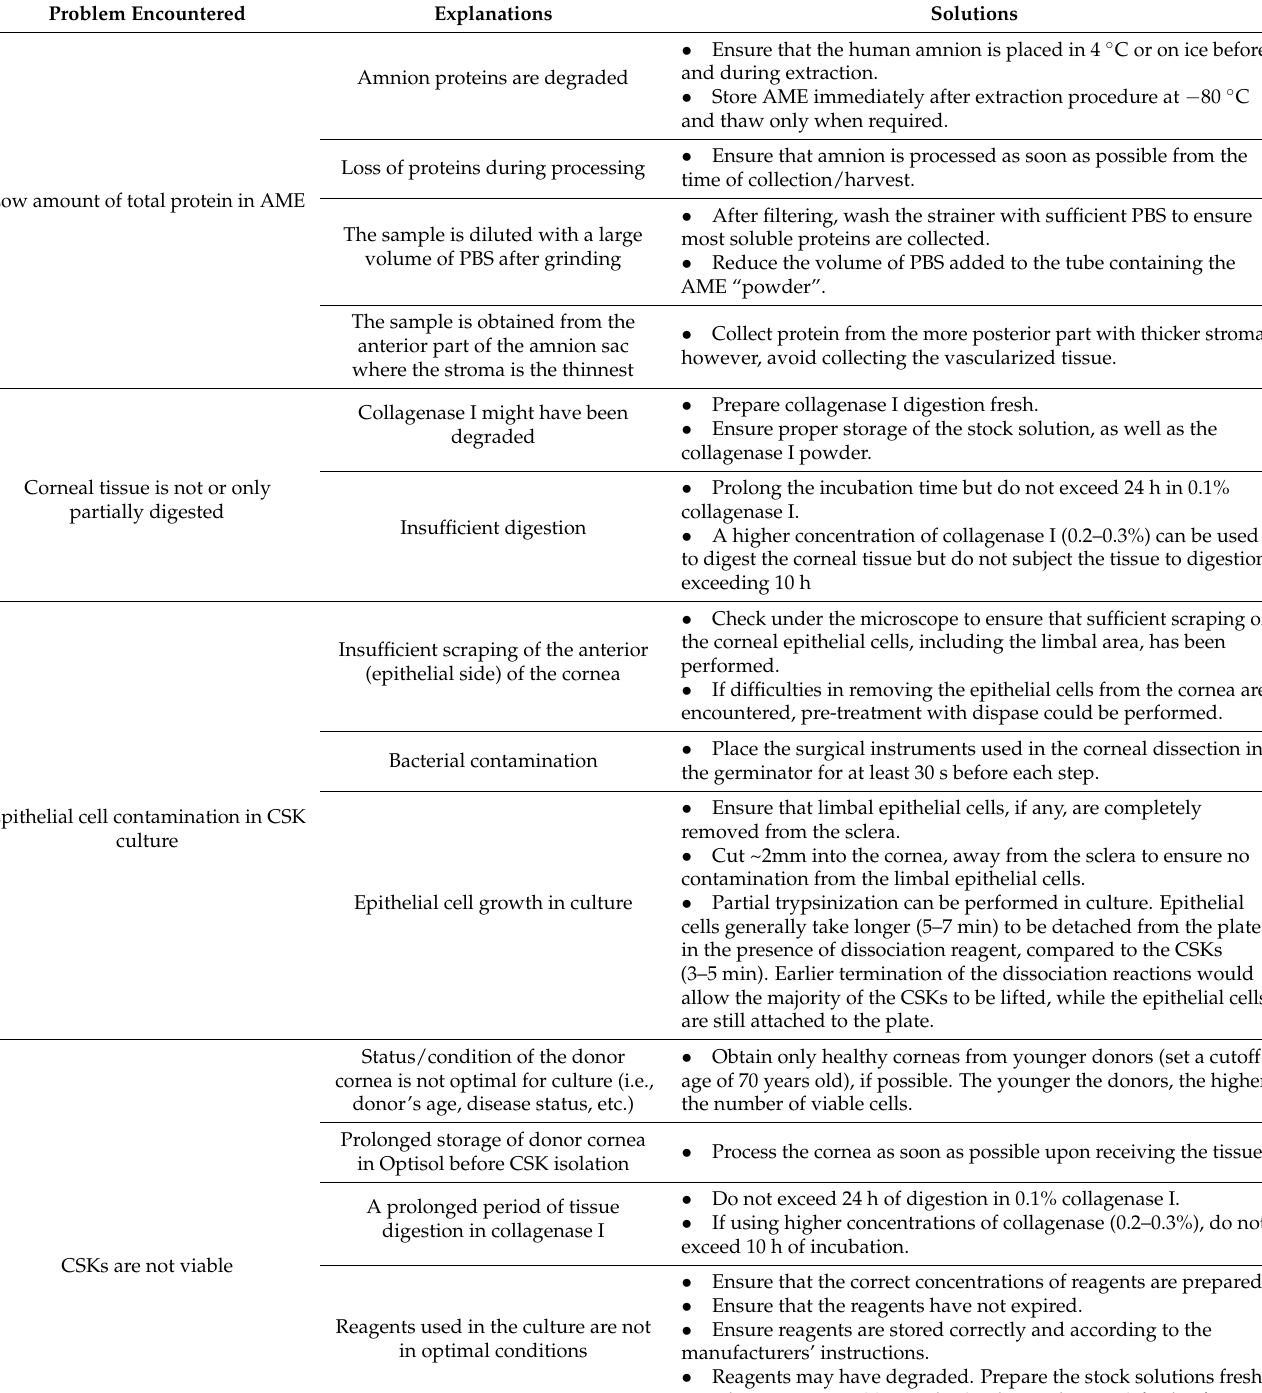
Table 1. Potential problems that may arise during CSK culture and their respective